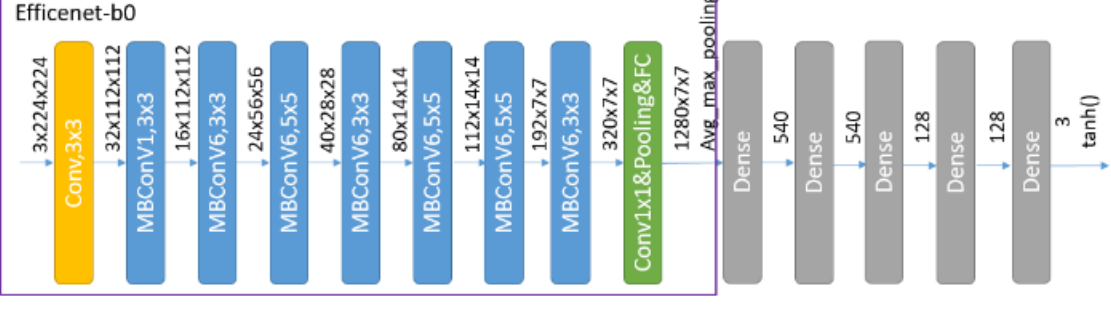
Figure 8. Behavior clone